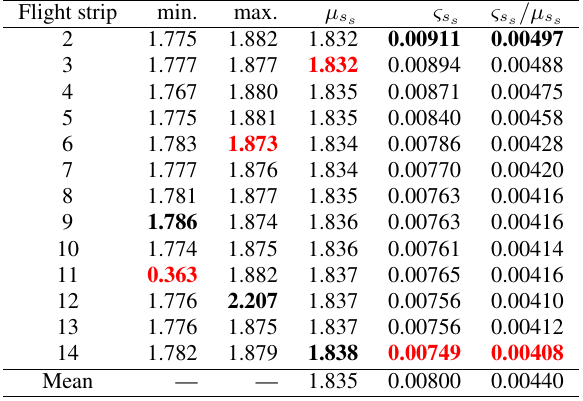
Table 4: Statistics for the system waveform widths s s of the 2005 campaign (unit: ns ). Bold figures denote the minima and maxima per category for the whole campaign, resp.